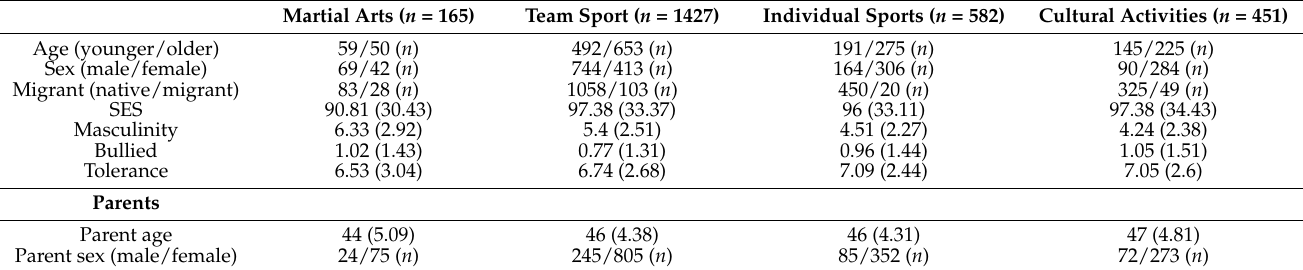
Table 1. Participant descriptors based on youth and parent